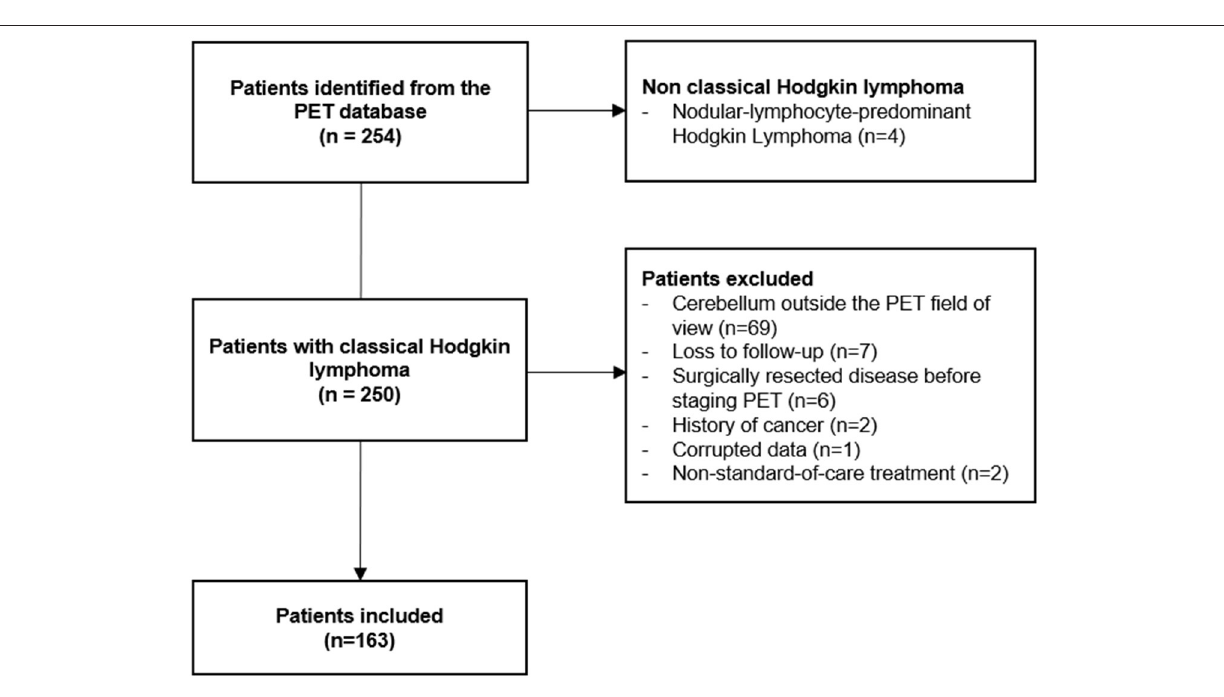
FIGURE 2 | Flowchart of patients’